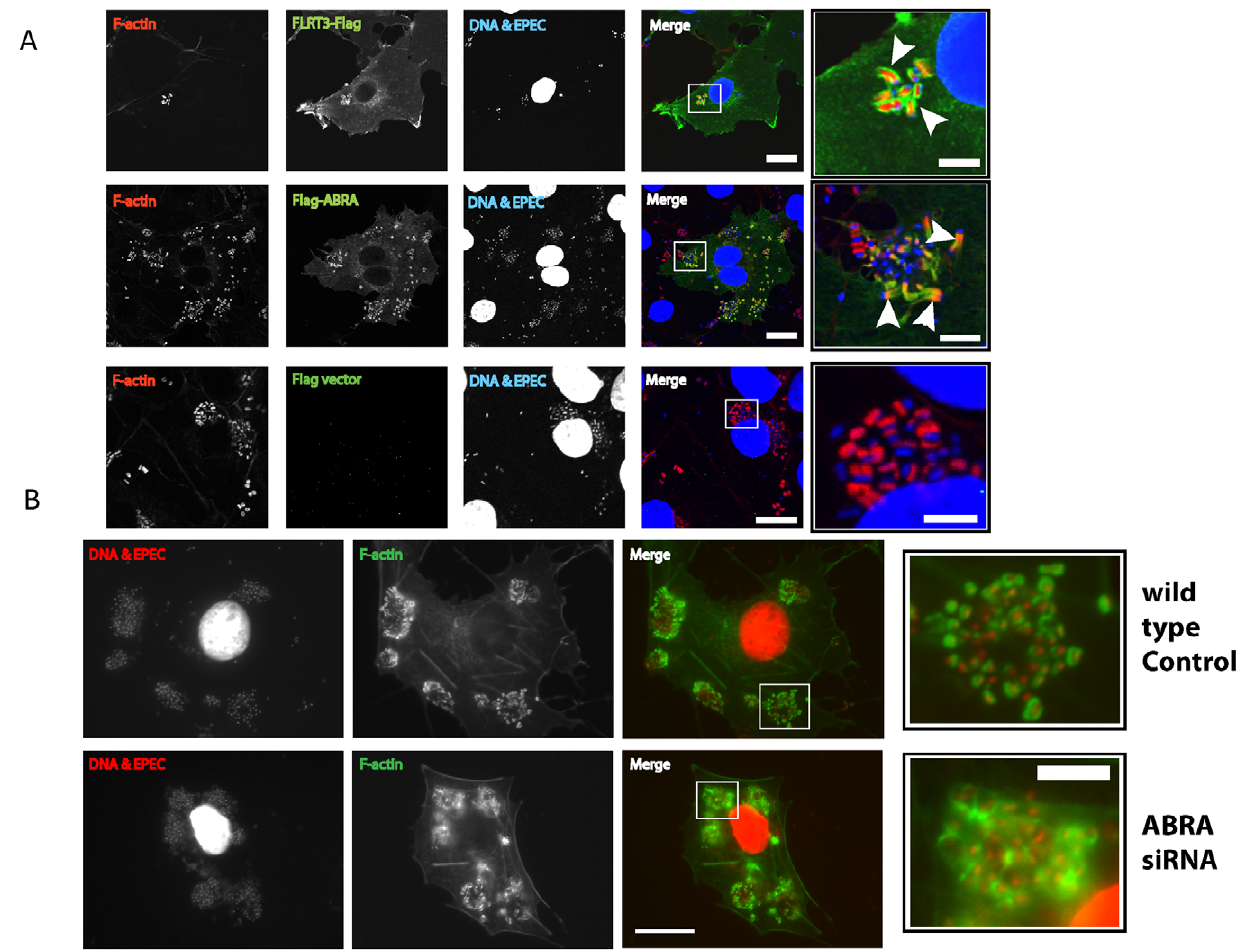
Figure 7. ABRA is necessary for correct pedestal formation. A. COS-7 cells transfected with empty pCMV-3xFlag vector, FLRT3-Flag or Flag- ABRA. Cells were infected with EPEC, fixed and stained with an anti-Flag antibody. FLRT3-Flag and Flag-ABRA are enriched at the EPEC pedestal (Arrowheads). B. Wild-type and ABRA knockdown cells were infected with EPEC for a total of 5 hours, fixed and stained with DAPI (red) and phalloidin (green). Pedestals in ABRA knockdown cells are disorganised (close-up). Scale bars=20 m m and 5 m m in close-up panels.